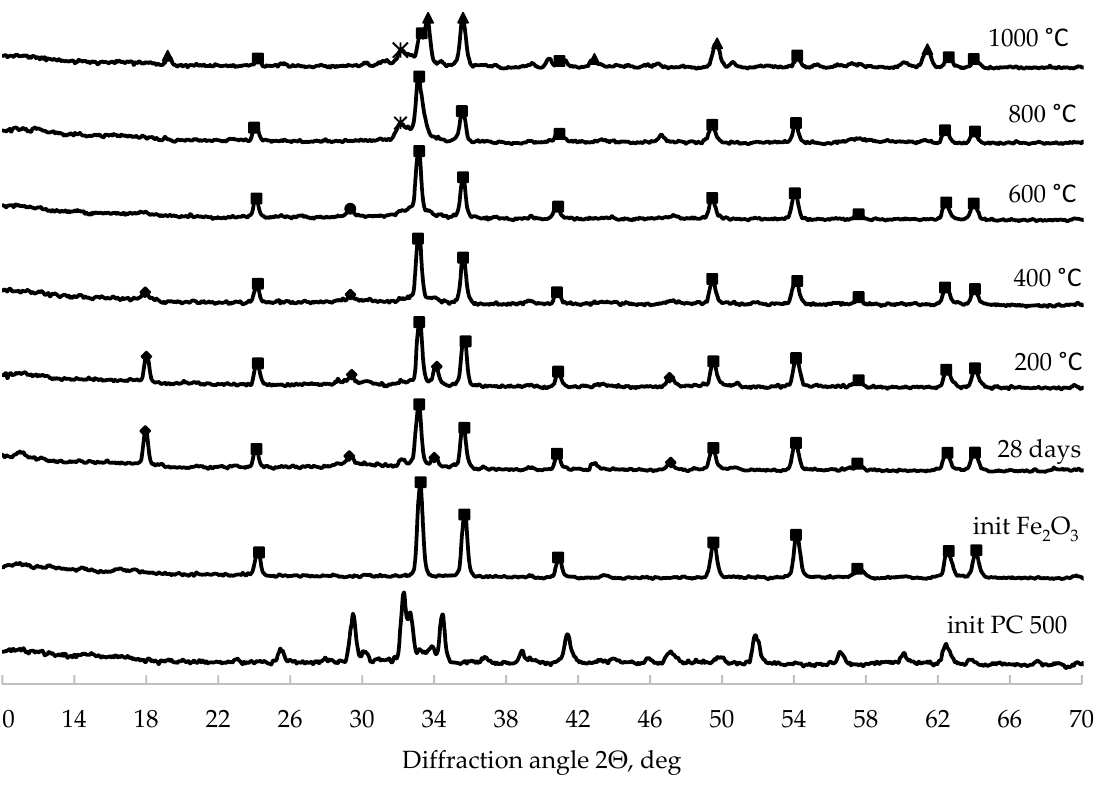
Figure 7. X-ray di ff raction pa tt ern of concrete specimens based on PCf mix after heat treatment: ■ = Fe 2 O 3 ; ◊ = Ca(OH) 2 ; ▲ = CaFe 2 O 4 ; * = Ca 2 SiO 4.